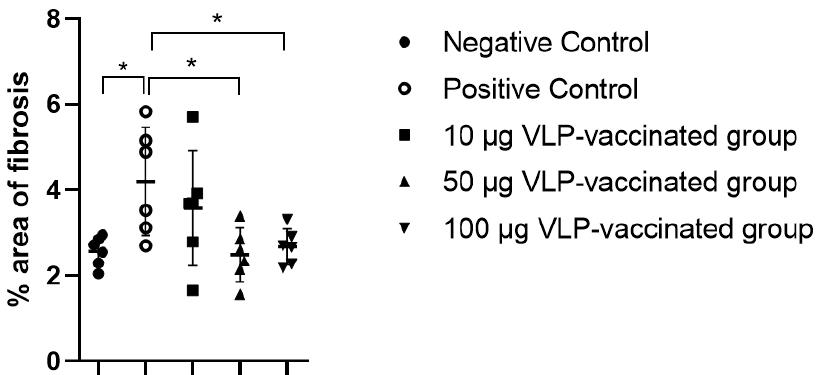
Figure 5. The percentage area of fibrosis in the Masson’s trichrome stained rabbit liver slides. The percentage of fibrotic tissue caused by swine HEV-3 infection in the liver of the positive control rabbits increased significantly compared to that in the liver of the negative control rabbits. The percentage of fibrotic tissue in the liver of rabbits vaccinated with 10 μg VLP appeared to increase but was not statistically significant. Proliferation of fibrotic tissue caused by swine HEV-3 infection was prevented by vaccinating rabbits with 50 and 100 μg VLP. Differences were compared between the negative and positive control rabbits and between the positive control and vaccinated rabbits. * p < 0.05.